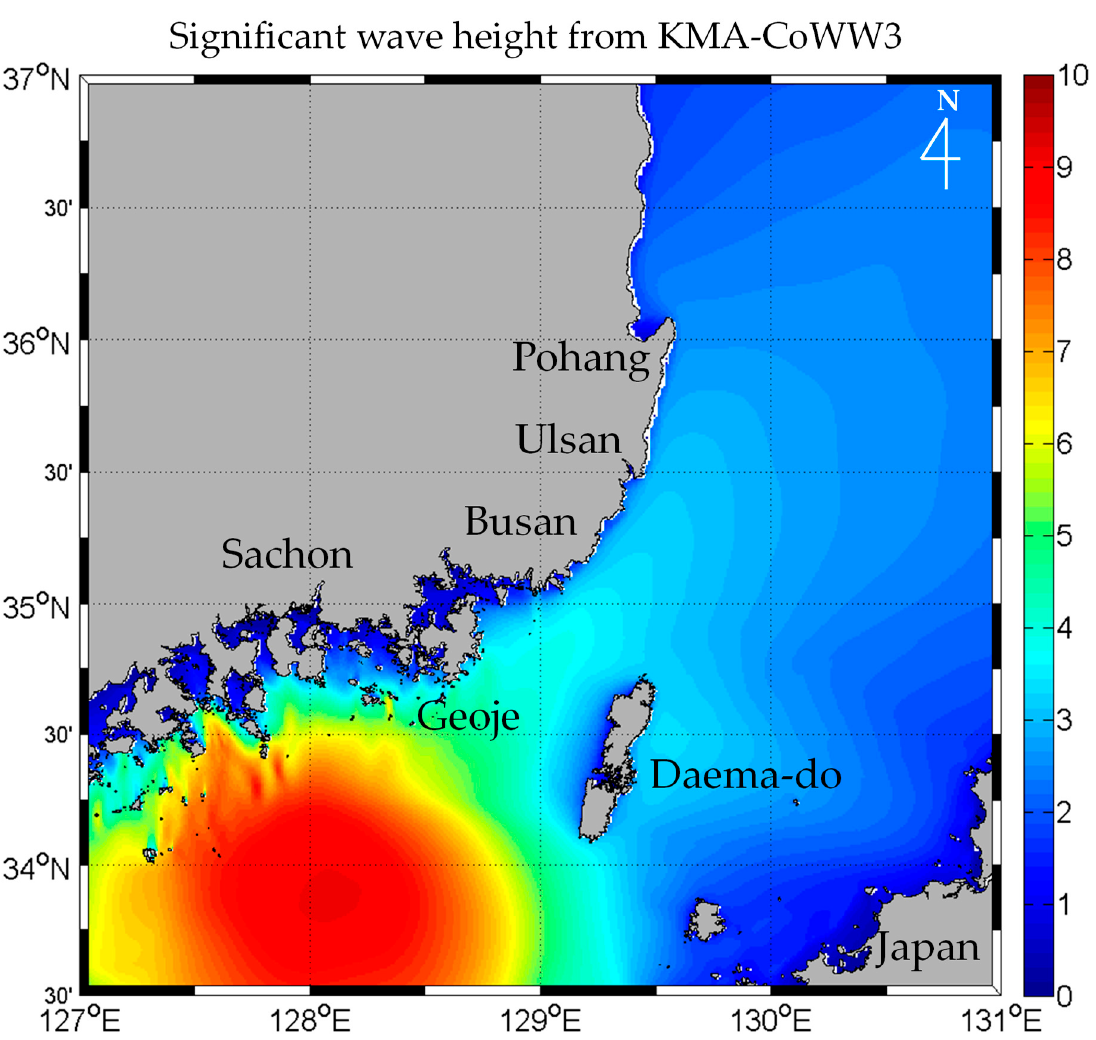
Figure 9. Contour map of simulated significant wave height near the application site .